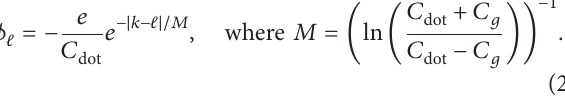
Figure 5: Temperature effect on the 2D and 3D source-drain